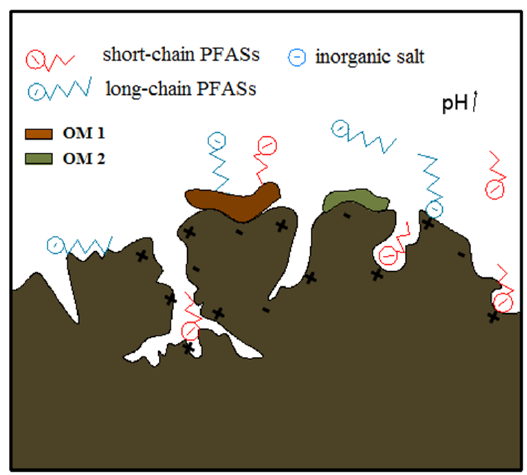
Figure 1. Adsorption mechanism of carbon-based adsorbents for PFAS removal.